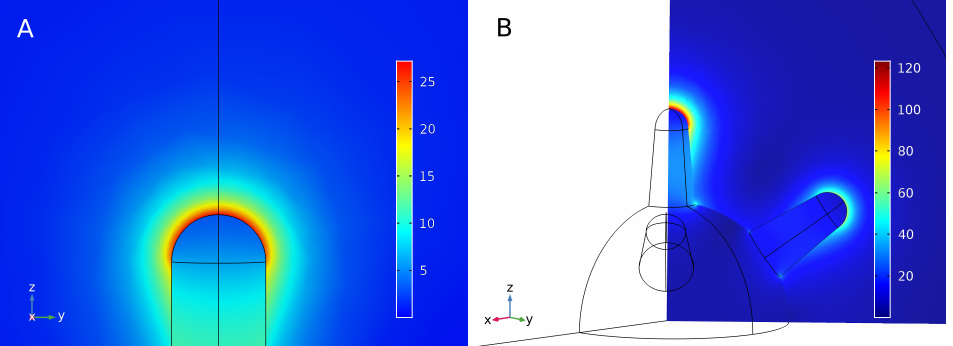
Figure 8. ( A ) Enhancement of the electric field on one tip of a NanoRod with aspect ratio 3.5 and situated in a 772 nm wavelength electromagnetic field and ( B ) of a NanoStar with 20 mm tip length situated in an 809 nm wavelength electromagnetic